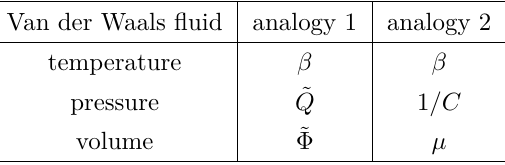
Table 1 . Two analogies between the thermodynamic variables of the Van der Waals fluid and those of the CFT thermal state dual to charged AdS black